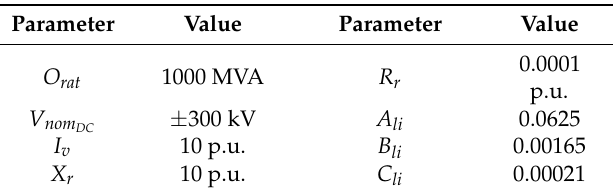
Table 1. Parameters of VSC-MTDC.